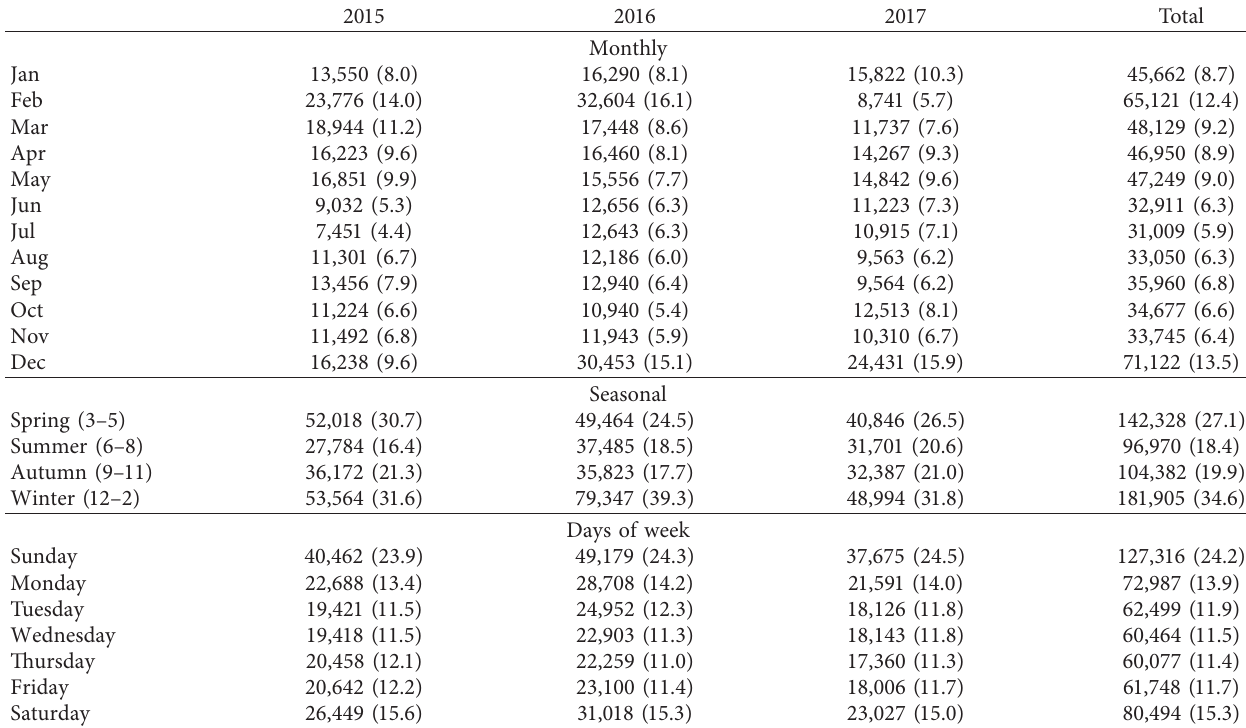
Table 2: Distribution of respiratory disease incidence in ED by year, month, season, and days of week N (%).